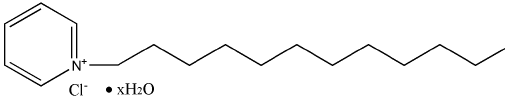
Figure 1. Chemical construction of DPC.